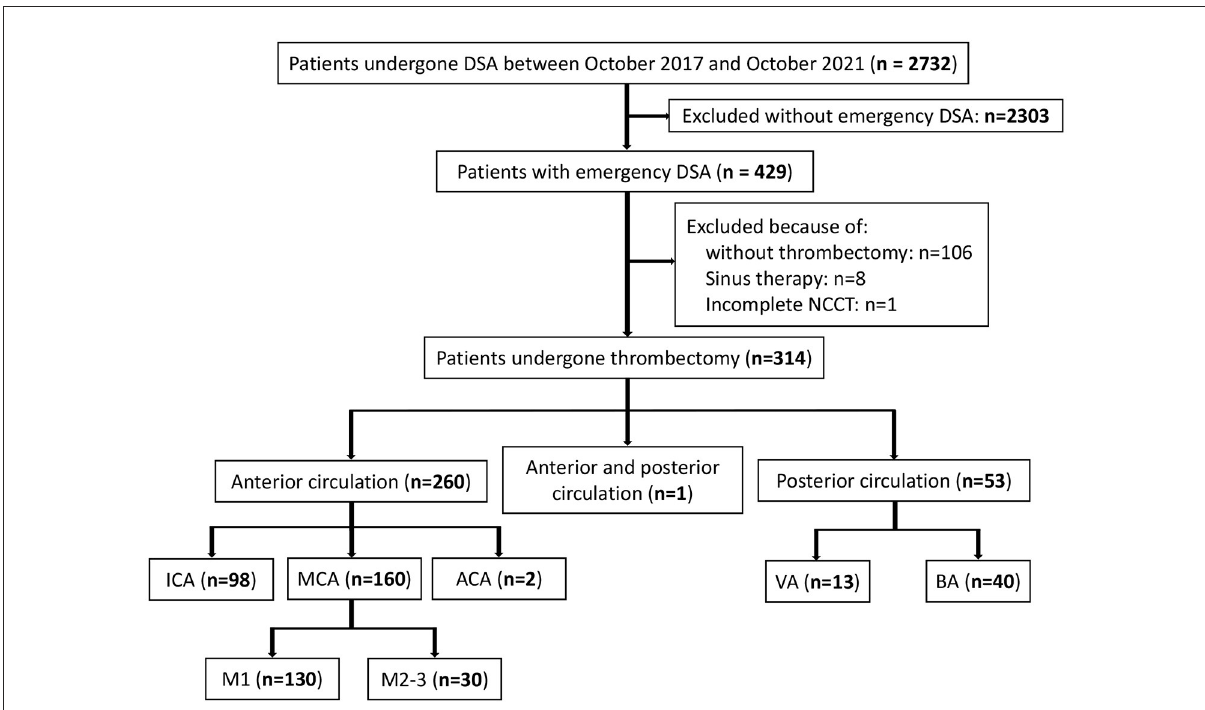
FIGURE1 Patients flow-chart of the cohort. DSA indicates digital subtraction angiography; NCCT, non-contrast CT; ICA, internal carotid artery MCA, middle cerebral artery; VA, vertical artery and BA, basilar artery.